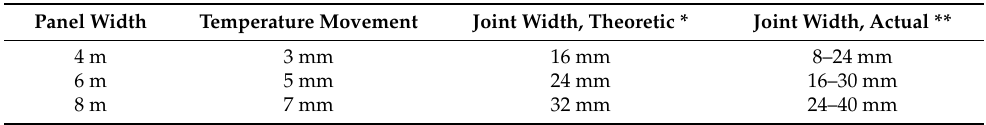
Table 3. Panel width and corresponding joint widths based on the rule of thumb for sealants [23,24]. Based on two equally sized panels.